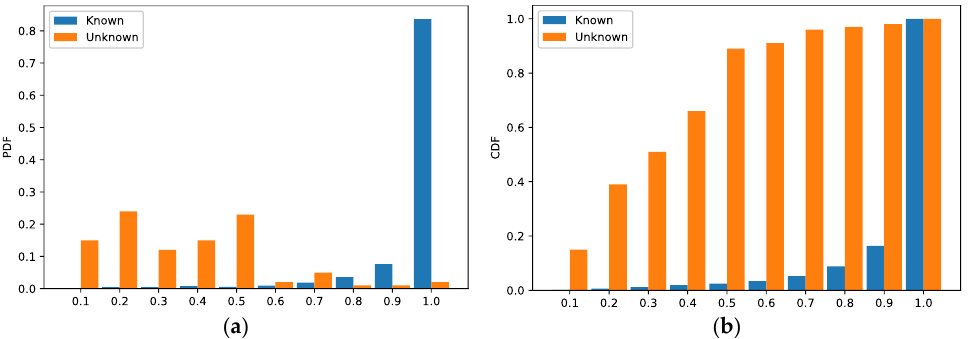
Figure 7. Evaluation results of the multi-classification model. ( a ) PDF ( b ) CDF.